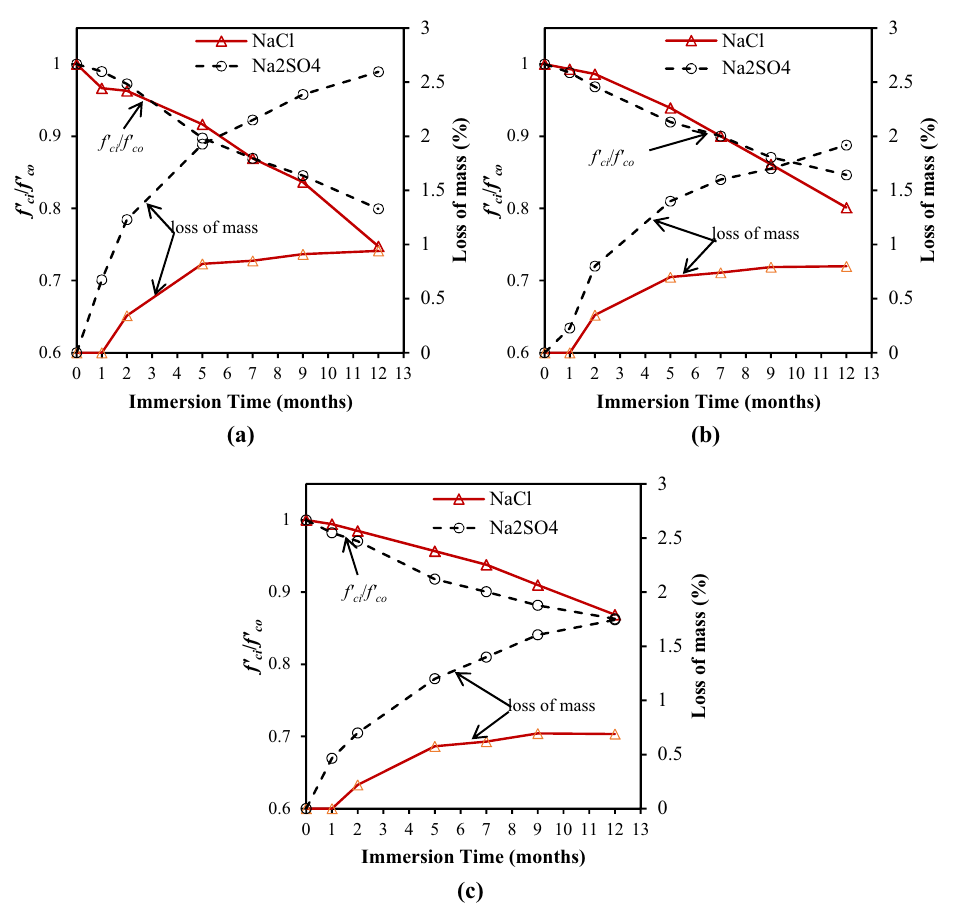
Figure 16: Comparison of mass loss and compressive strength degradation of UHPC with CDE at ( a ) 0%; ( b ) 5%; and ( c ) 10% after exposure to NaCl and Na 2 SO 4 solutions.